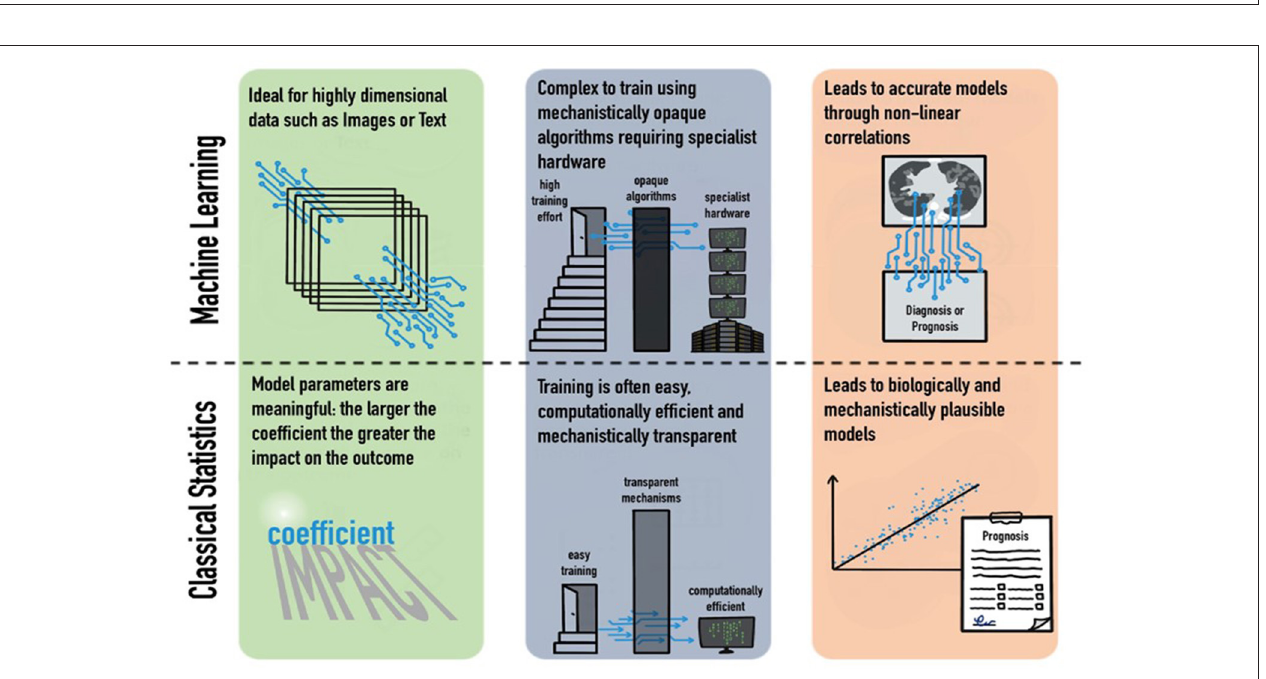
FIGURE 1 | Strengths and weaknesses of machine learning and classical statistics in their domains, training requirements, and outputs.